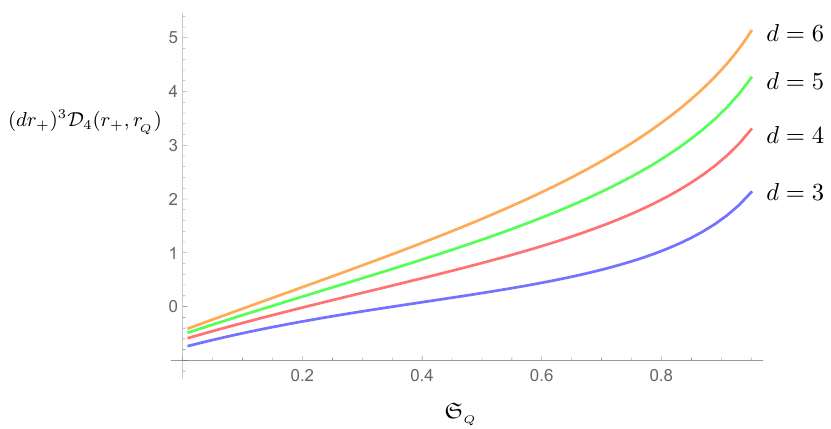
and have plotted the coefficient +